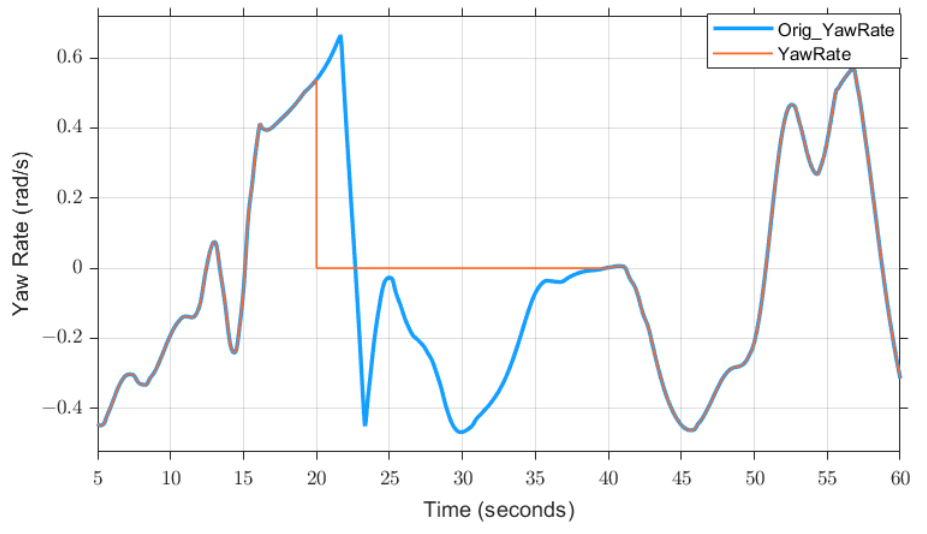
Figure 22. IMU sensor data, which fails between 20 s and 40 s (the blue line refers to the displayed data when the sensor does not fail, the red line refers to the displayed data when the sensor fails).